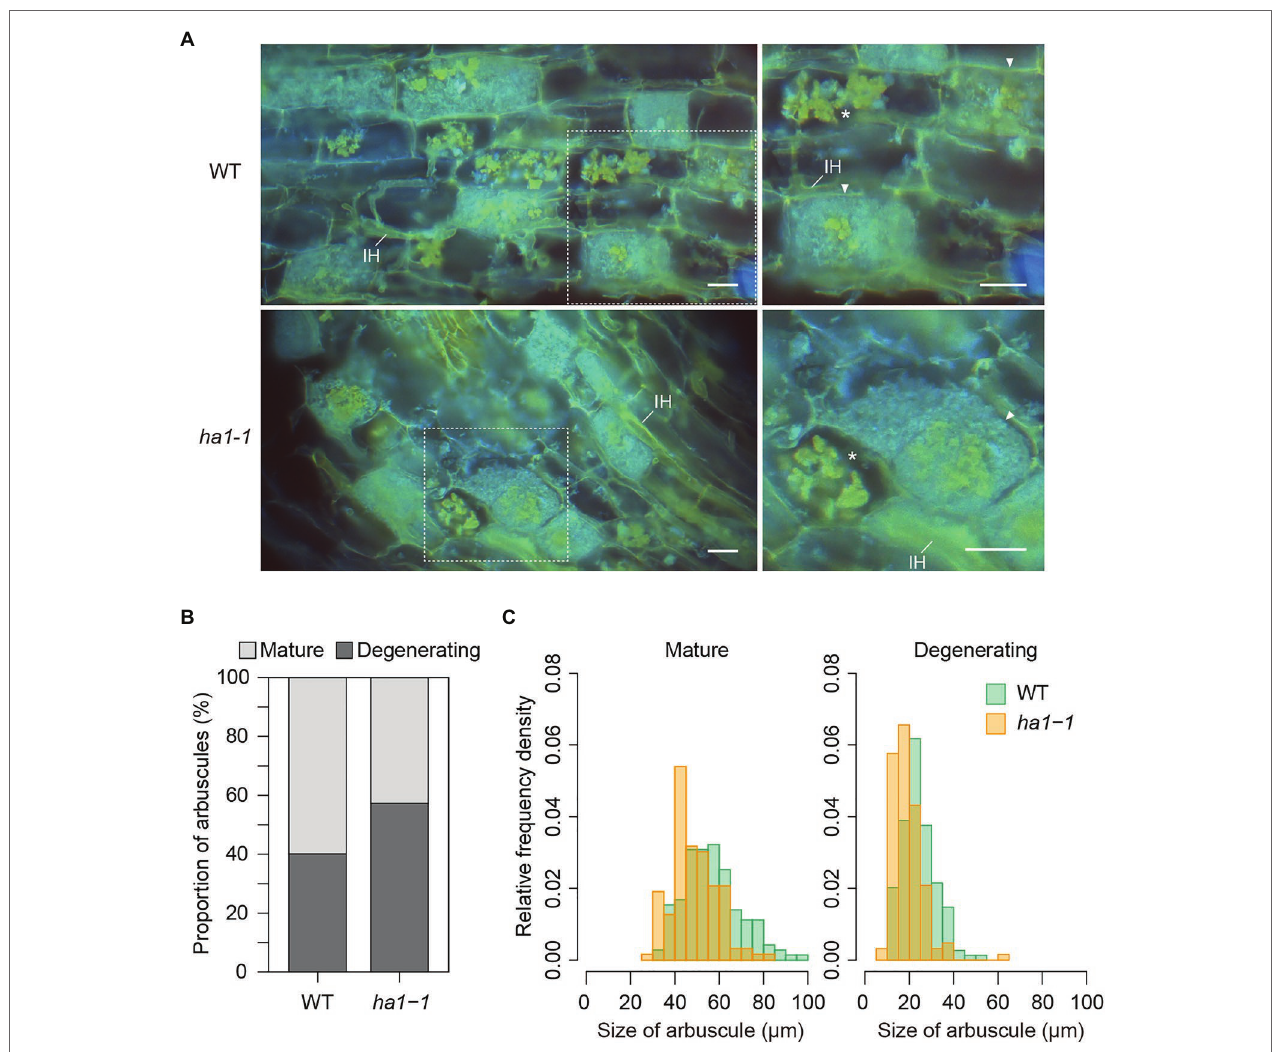
FIGURE 2 | Mature and degenerating arbuscules stained with 4 ′ ,6-diamidino-2-phenylindole (DAPI). (A) DAPI staining of arbuscules in wild-type (WT) and ha1-1 roots of Lotus japonicus . Mycorrhizal roots were harvested 4 weeks after inoculation with Rhizophagus irregularis . Cryosections of fresh roots were stained with DAPI and observed using an epifluorescence microscope. The DAPI-polyP complex emits yellow fluorescence under UV irradiation. Blue fluorescence suggests non- specific DAPI binding to fungal hyphae. Right panels show the magnified images of dotted areas in the left panels. Mature arbuscules (arrowheads) and degenerating arbuscules (asterisks) are visible. IH: intraradical hypha. Scale bar = 20 μ M. (B) Proportion of mature and degenerating arbuscules in WT and the ha1-1 mutant. Small, shrunk arbuscules that entirely show intense yellow fluorescence by DAPI staining were considered as degenerating arbuscules. Mature arbuscules fully occupy plant cortical cells. The proportion was significantly different based on Fisher’s exact test ( p < 0.001, n = 499 and 562 in WT and ha1-1 , respectively). (C) Relative frequency density of the size of mature and degenerating arbuscules formed in WT and ha1-1 . The lengths of the major axis of arbuscules stained with DAPI were measured. The size distribution was significantly different between the plant genotypes according to the two-sample Kolmogorov-Smirnov test in each arbuscule type ( p < 0.001). Mature arbuscule: n = 143 and 146; degenerating arbuscule: n = 149 and 125 in WT and ha1-1 ,